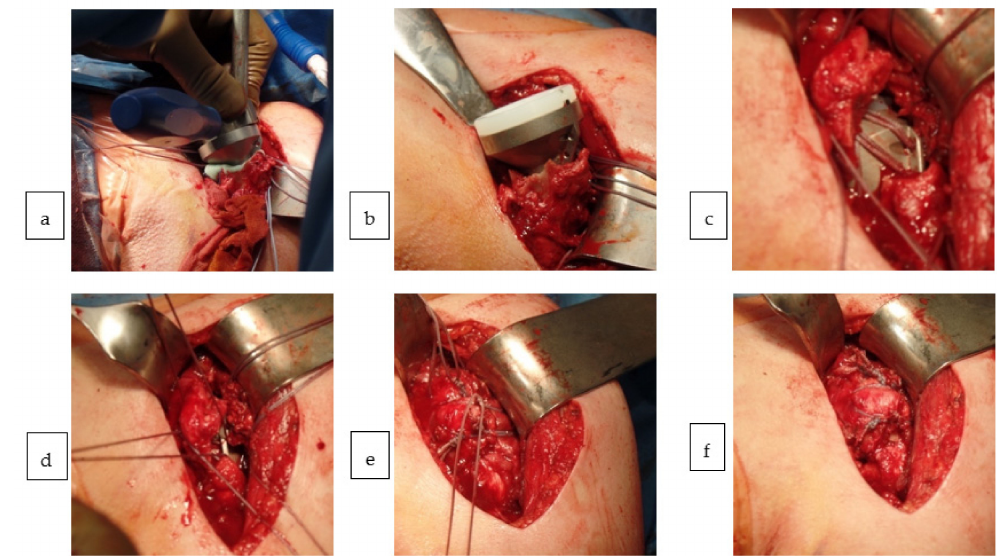
Figure 2. Tuberosity repair with the conventional stem: After fracture exposure and placement of four sutures, two through the anterior and two through the posterior cuff, cementation was followed with stem implantation ( a ). Removal of excessive cement allowing bony tuberosity integration around the metaphysis was then followed by inlay positioning ( b ). Tensioning the anterior and posterior sutures through the fins (only for the conventional stem) ( c ) before aligning both tuberosities around the metaphysis of the stem ( d ). Closing the anterior and posterior sutures ( e ) and preventing the butterfly effect through the use of an additional, medial cerclage ( f